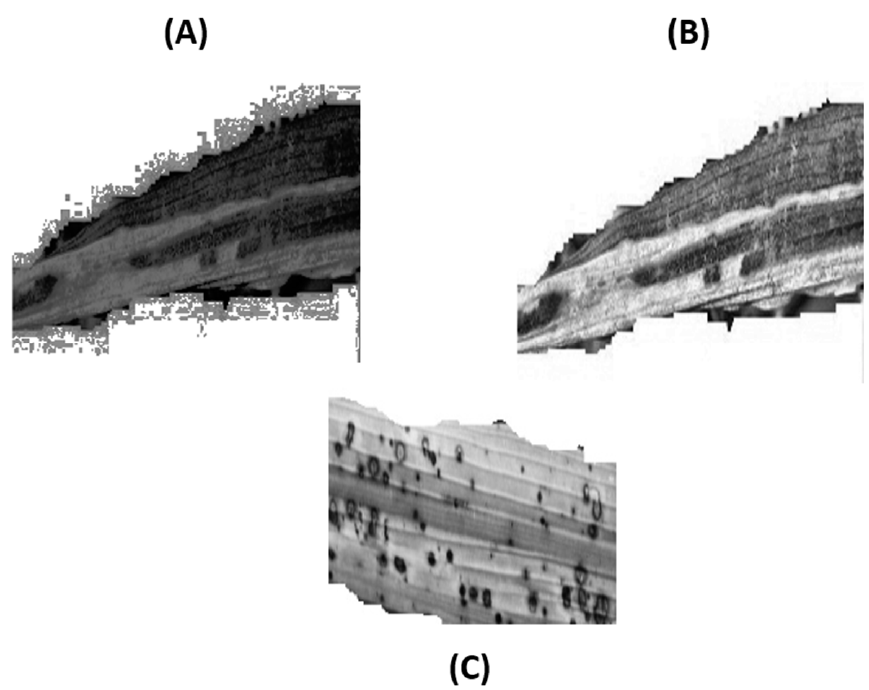
Figure 6. Equalization comparison: ( A ) Global; ( B ) CLAHE for blight; ( C ) CLAHE for smut.